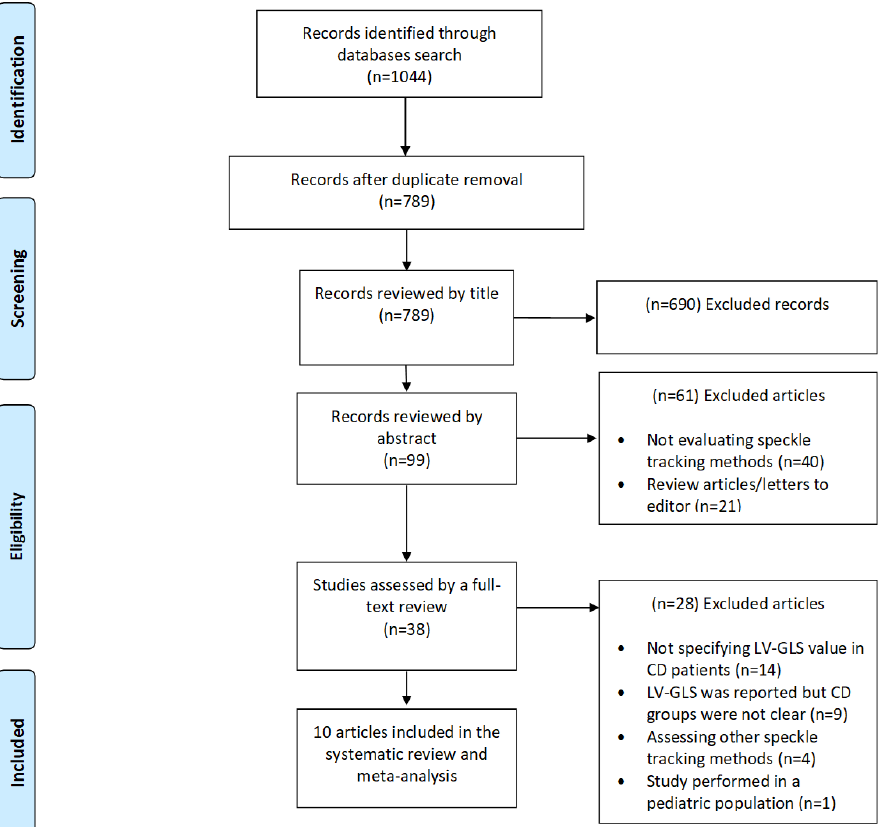
Figure 1. Flowchart summarizing study selection process.